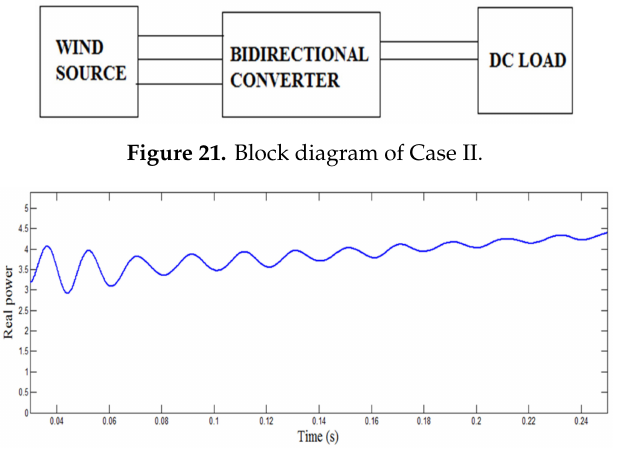
Figure 22. Real power from generation.